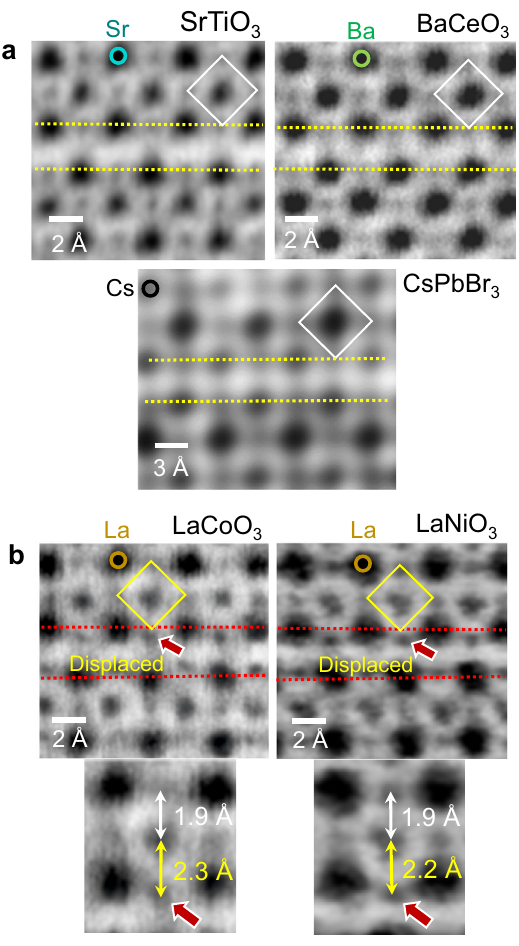
Fig. 2 ABF-STEM images of the shear faults to visualize the position of anions. a As denoted by a white square diamond in each image, no distortion of anion octahedra is observed at the faults (yellow broken lines) in SrTiO 3 , BaCeO 3 , and CsPbBr 3 . b In contrast, as indicated by a red arrow in each image, substantial displacement of oxygen anions at the fault planes should be noted in LaCoO 3 and LaNiO 3 , showing the position deviation from the yellow square diamonds. Magni fi ed images directly provide quantitative information on the elongation of bond lengths in Co – O (2.3 Å) and Ni – O (2.2